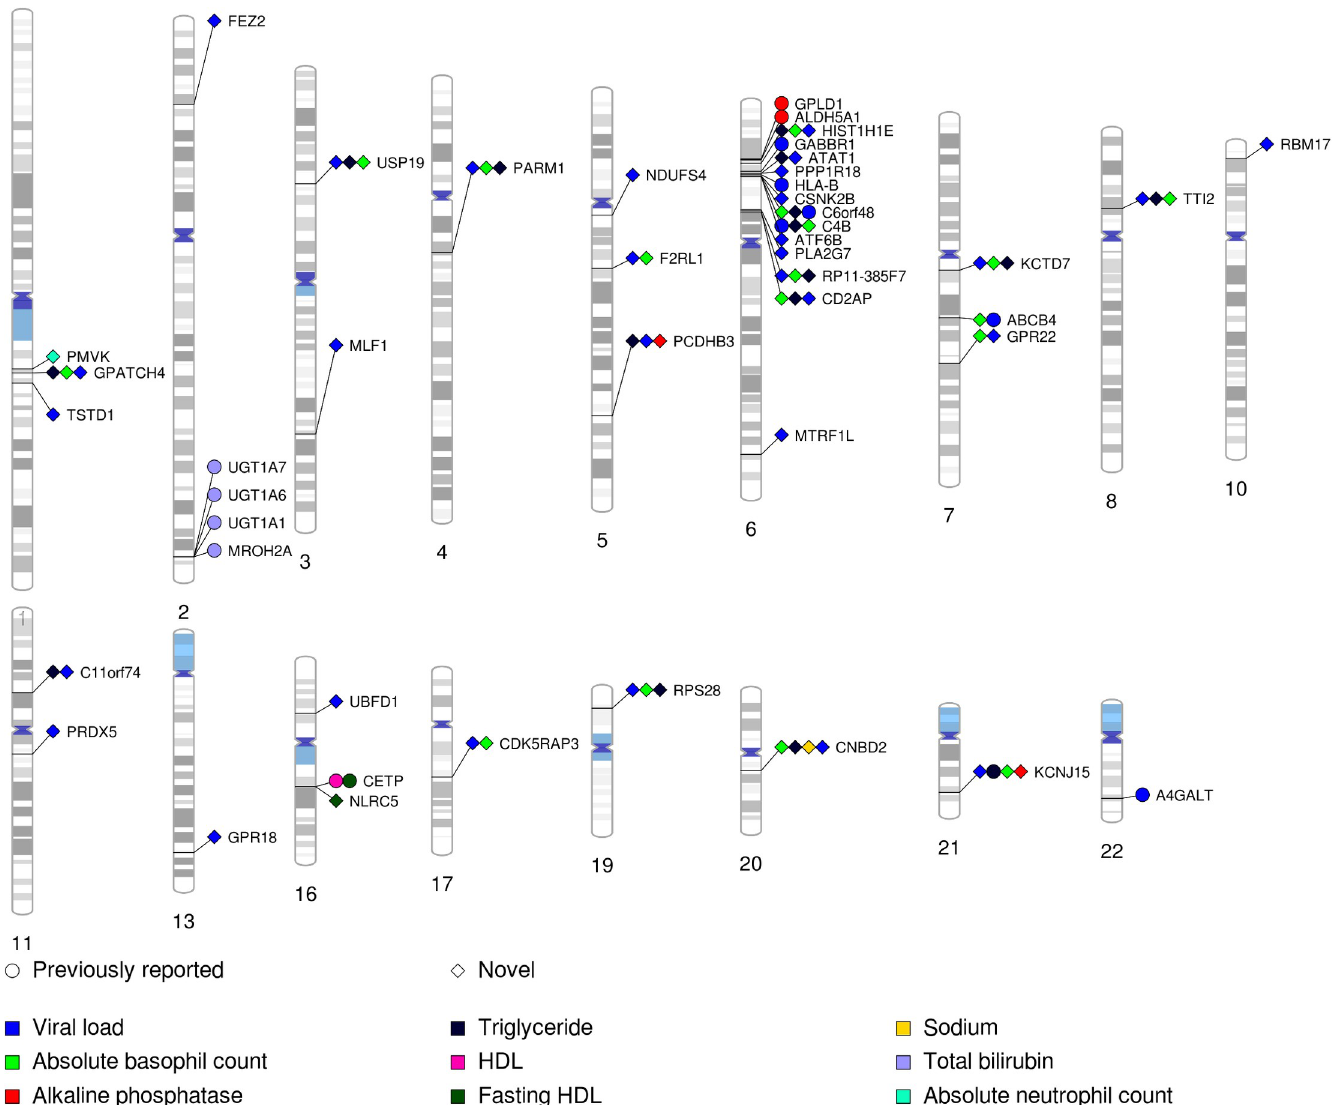
Fig 8. PhenoGram of statistically significant gene-trait associations identified by the TSA-TWAS analytic framework. We plotted the associations with p- value < 1.12 × 10 − 7 . Each association is arranged according to the SNP location on each chromosome and the points are color-coded by baseline laboratory values. Diamonds represented previously reported or replicated associations, and circle represented novel associations identified in this